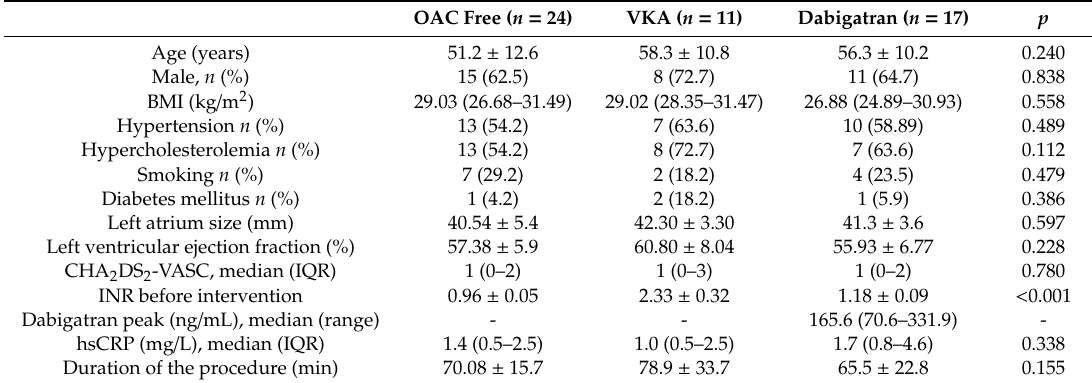
Table 1. Baseline clinical and procedural